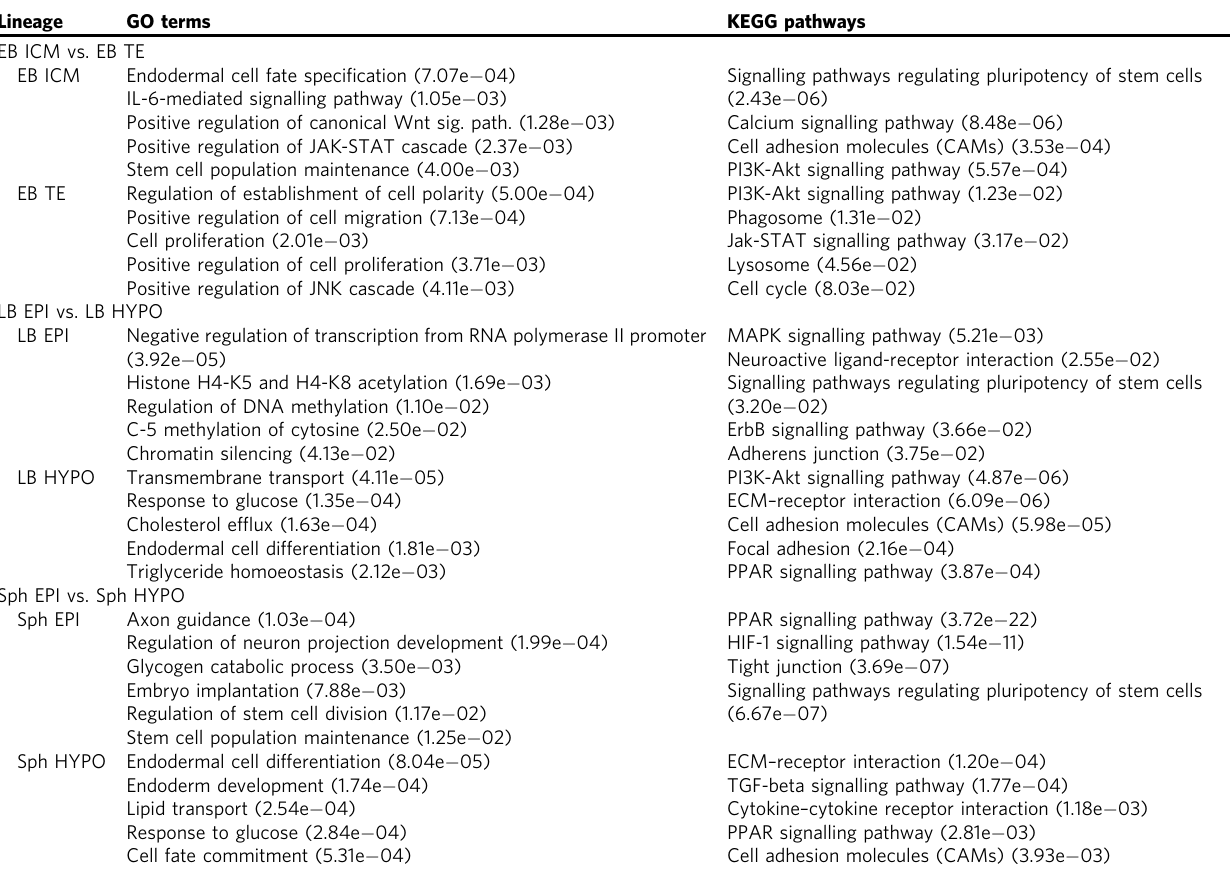
Table 2 Gene ontology terms and KEGG pathways determined by pairwise comparisons of embryonic lineages